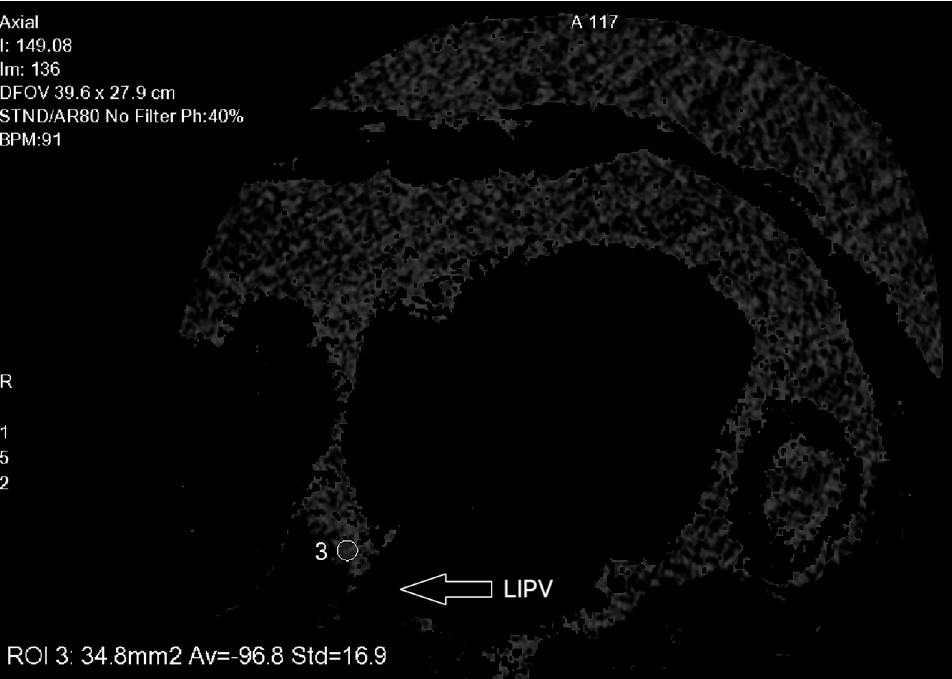
Figure 4. EAT measurement: Inferior left region (IL) near the LIPV (left inferior pulmonary vein) ostium.